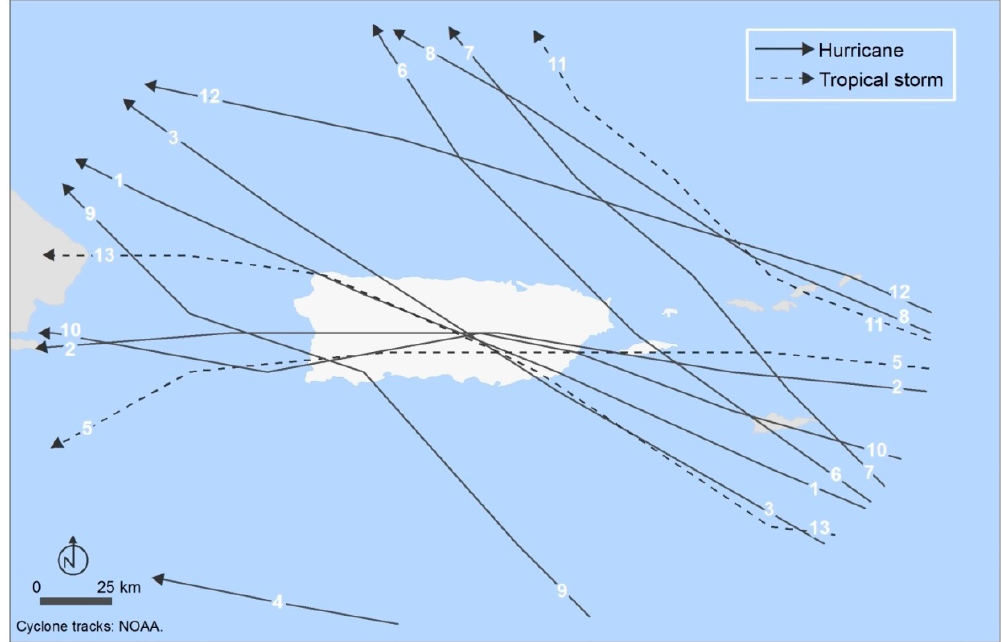
Figure 1. Trajectories of hurricanes studied in the examined articles. The 13 hurricanes that passed within 138 km of Puerto Rico identified by number are 1. San Felipe II (1928) 2. San Ciprián (1932) 3. Betsy (1956) 4. David (1979) 5. Frederick (1979) 6. Hugo (1989) 7. Marilyn (1995) 8. Bertha (1996) 9. Hortense (1996) 10. Georges (1998) 11. José (1999) 12. Debbie (2000) 13. Jeanne (2004). Three other hurricanes that passed at a greater distance are not shown in this map (see Forest and Cyclones in Puerto Rico: A Brief Overview section).